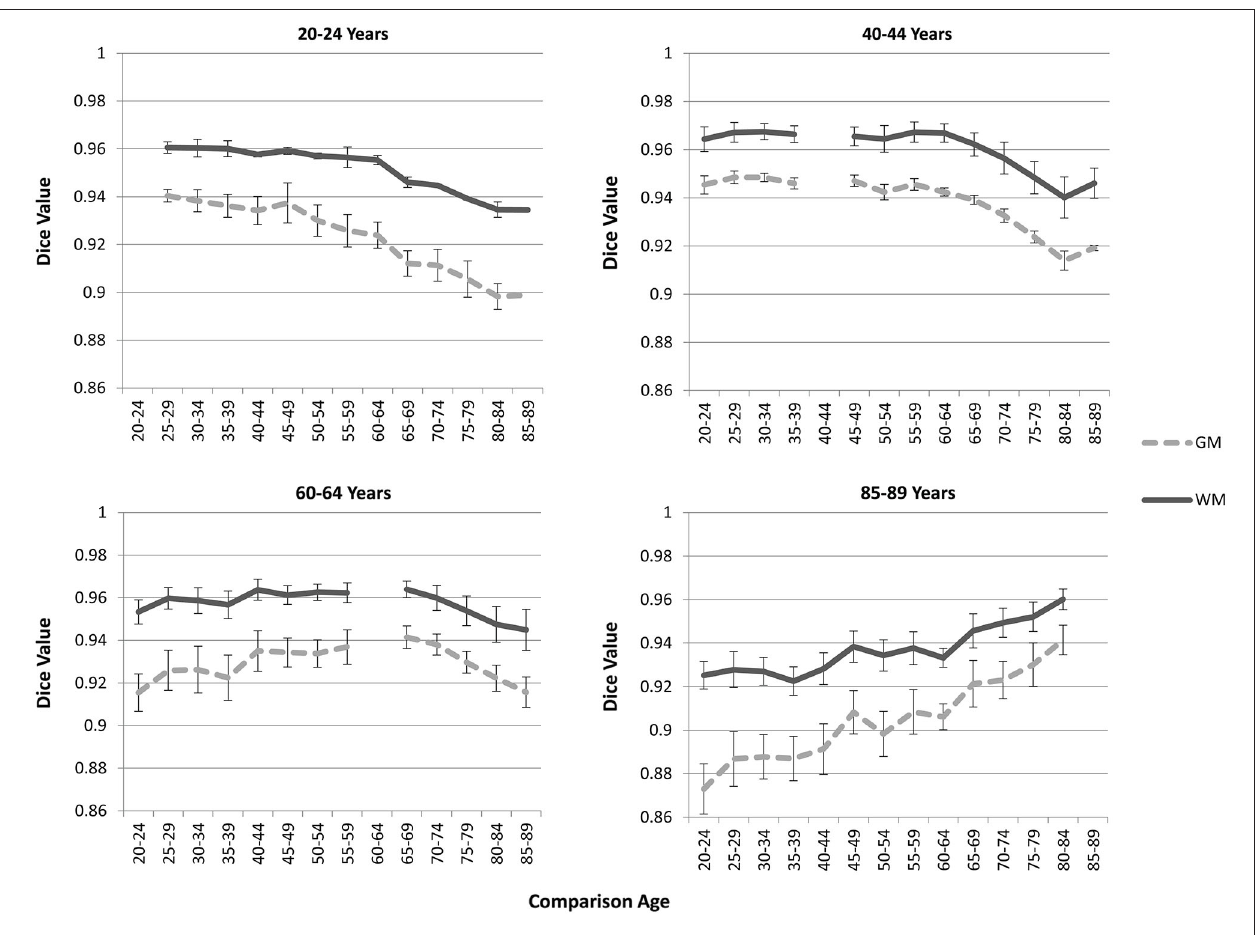
priors derived from younger and older age groups. These PVE’s were compared, and mean Dice similarity values are shown for several representative ages. Note the consistent drop off in similarity, as utilized priors grow farther from the appropriate age